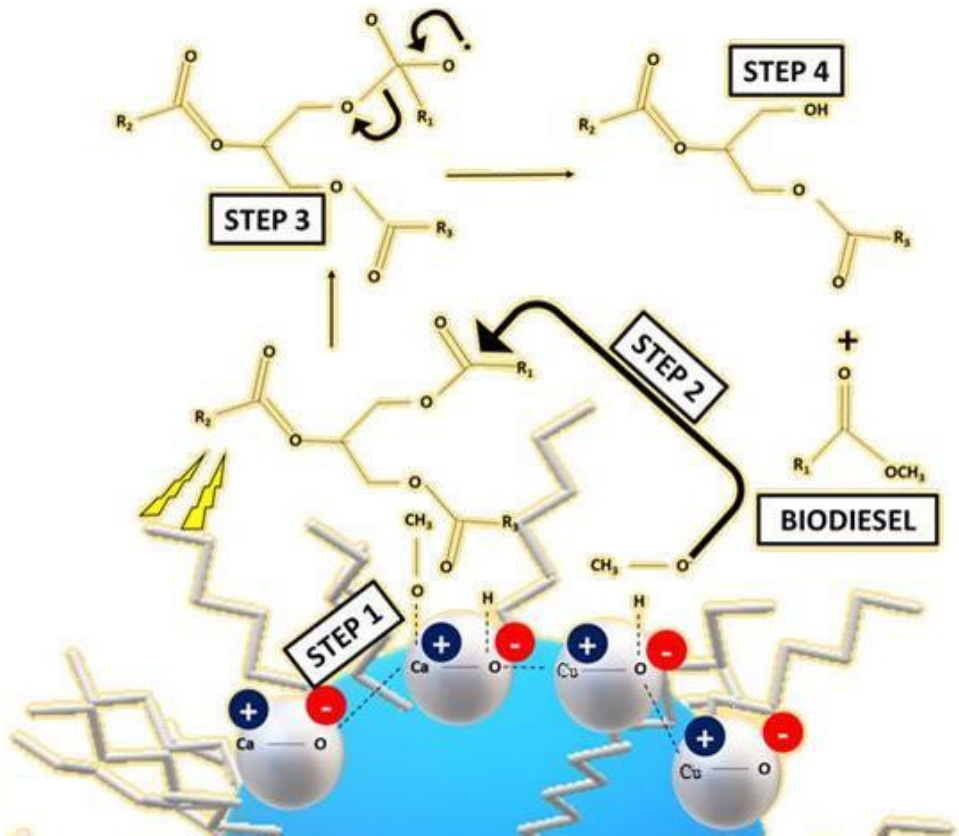
Figure 7. Transesterification of triglycerides into biodiesel by using basic CaO-CuO/C 6 catalyst.